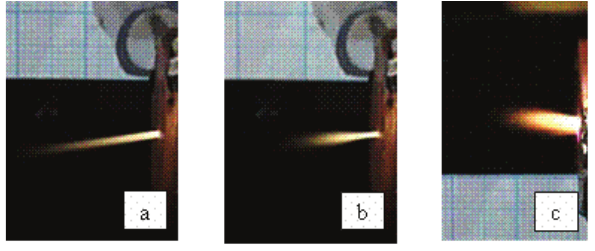
Figure 6: Photos of the microdischarge plasma jet, which is blowing out from the negative flat electrode with gas outlet of diff erent diameters: а), b) d = 0.5 mm; c) d =1.7 mm. Interelctrode gap is l = 3 mm, air flow is: а) and c) G = 0.5 L min -1 ; b) G = 3 L min -1 .